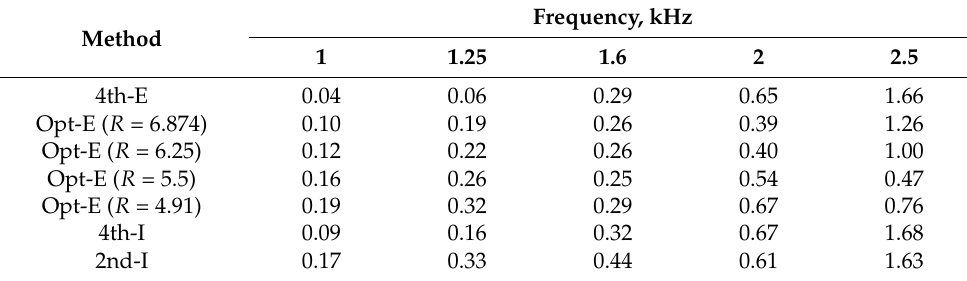
Table 3. Comparison of e C (dB) among various